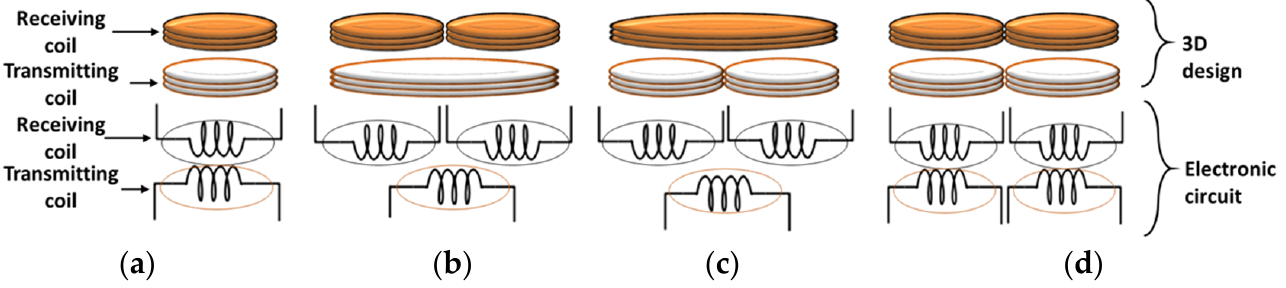
Figure 8. Wireless charging system architectures: ( a ) singular input singular output (SISO), ( b ) singular input multiple output (SIMO), ( c ) multiple input singular output (MISO), and ( d ) multiple input multiple output (MIMO).